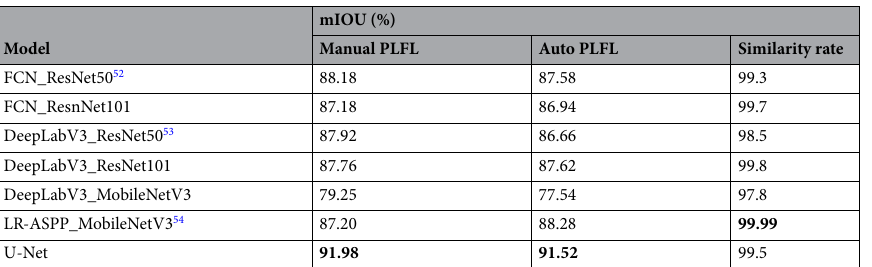
Table 8. Label suitability assessment through multiple segmentation networks. The use of manually generated PLFLs as targets is referred to as “Manual-PLFL” and while “Auto-PLFL” refers to the usage of PLFLs generated by our system as training targets. Best results are shown in [bold].